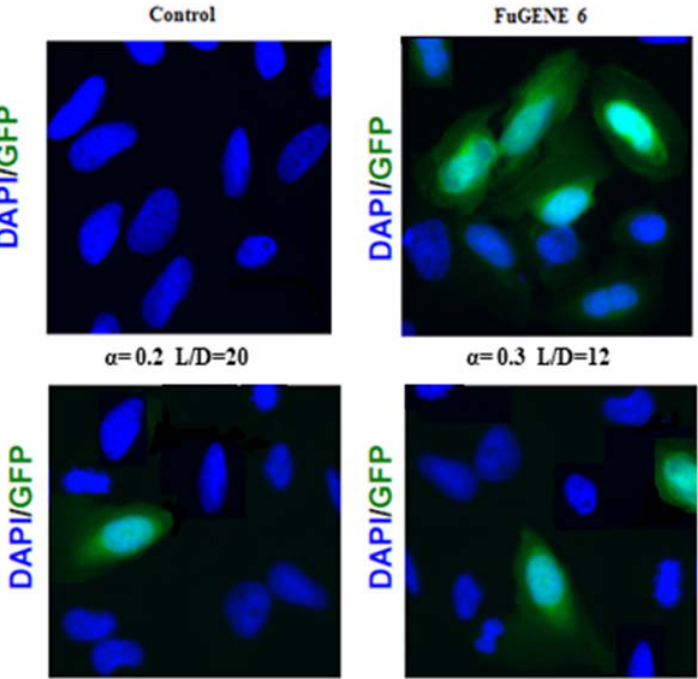
Figure 11. Representative images of GFP positive cells after transfection with 3 µ g of pDNA with DOPE/NBr/pDNA lipoplexes at α = 0.2 and L/D = 20 and at α = 0.3 and L/D = 12.